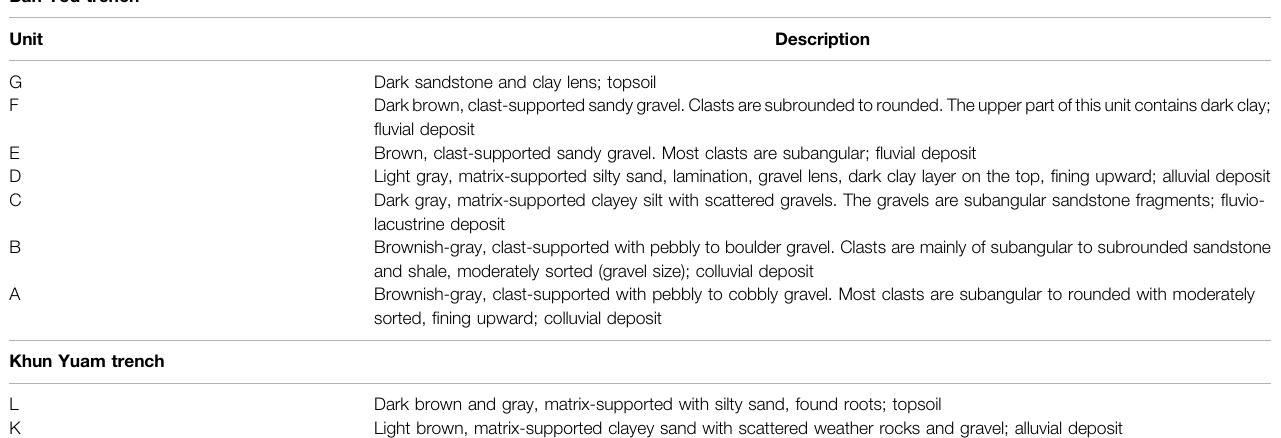
TABLE 1 | Description of stratigraphic units in trenches at Ban Yod, Khun Yuam, and Mae Tha Lu, as presented in Figures 6 – 8 . Ban Yod trench